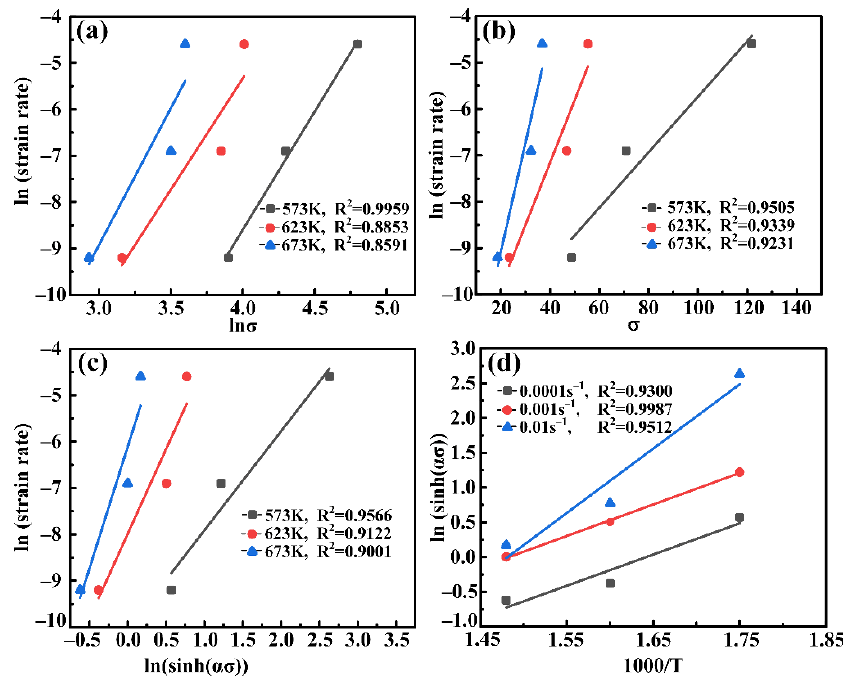
Figure 4. The linearly fitting relationship of as-extruded Mg–6Zn–5Ca–3Ce alloy fabricated by RS: ( a ) . . . ε − ln σ ; ( b ) ln ε − σ ; ( c ) ln ε − ln [ sinh ( ασ )] and ( d ) ln [ sinh ( ασ )] − 1000